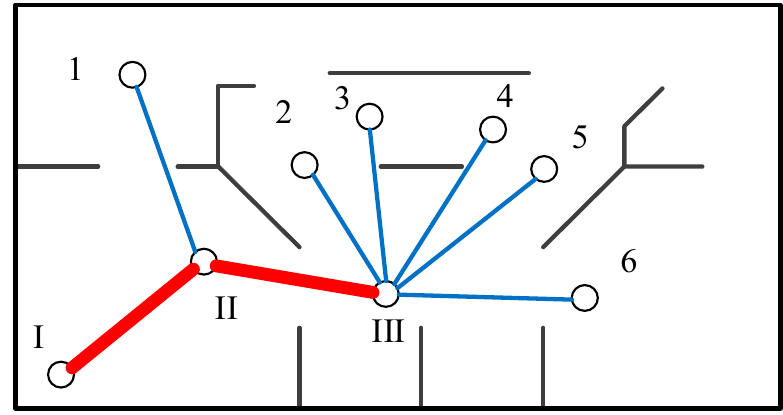
Figure 5. Updating the information gain of the topology map.